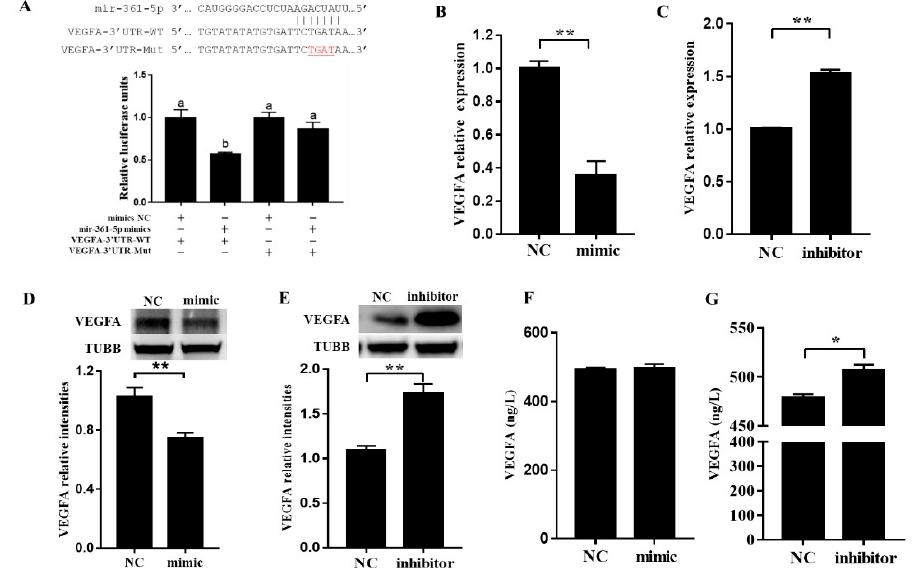
Figure 3. Negative regulation of VEGFA by miR-361-5p through direct 3 (cid:48) UTR binding. ( A ): The direct targeting of VEGFA by miR-361-5p confirmed by luciferase reporter assay in 293 cells (plus ( + ) indicates addition of oligos, minus ( − ) indicates no addition of oligos); ( B , C ): The mRNA levels of VEGFA after transfection of miR-361-5p mimics or inhibitors in porcine GCs; ( D , E ): The protein levels of VEGFA after transfection of miR-361-5p mimics or inhibitor in porcine GCs; ( F , G ): The levels of VEGFA after transfection of miR-361-5p mimics and inhibitors in culture media. n = 3 cell culture wells per group. Data are expressed as the mean ± SEM. Significant di ff erences ( p < 0.05) are indicated by di ff erent letters or * p < 0.05, ** p < 0.01.